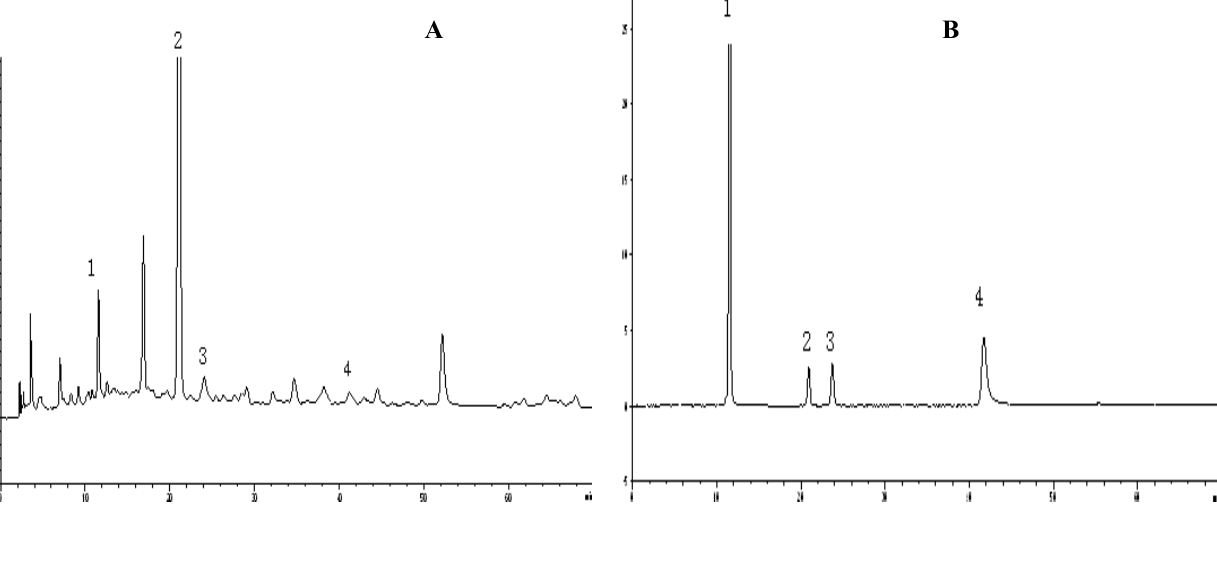
Figure 1. HPLC chromatograms of P-60 extract and the reference compounds. A